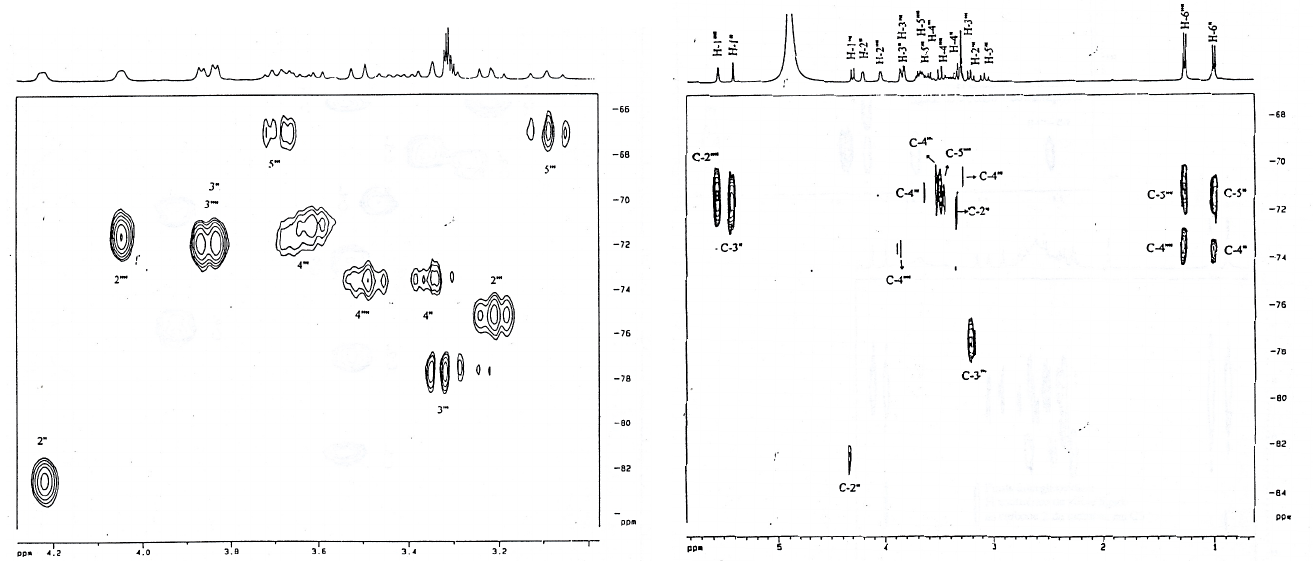
Figure S5 . HMQC spectrum of sagittatin A (300 MHz; CD 3 OD). Magnification of 4.0 – 8.0/80-140 ppm region.